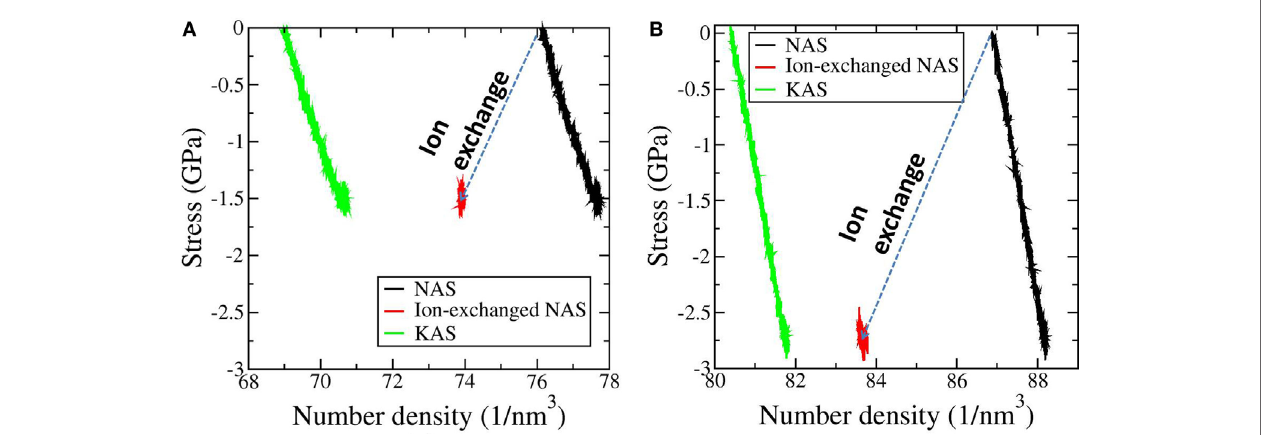
FigUre 1 | stress-number density plot during mechanical compression (black curves) and ion exchange (red curves) for the sodium aluminosilicate glass (nas) with high free volume in (a) and the sample with low free volume in (B) . The mechanical compression curve for the as-quenched potassium- aluminosilicate glass (KAS) with the same composition as the ion-exchanged NAS is also shown for comparison (green curves). Note that the ion exchanged sample has a higher number density than its compositionally equivalent as-quenched counterpart at the same compressive stress. In short, ion exchange densifies the sample beyond the mechanical stress. The sample with low free volume has higher compressive stress after ion exchange. In other words, decreasing free volume increases the Cooper coefficient.